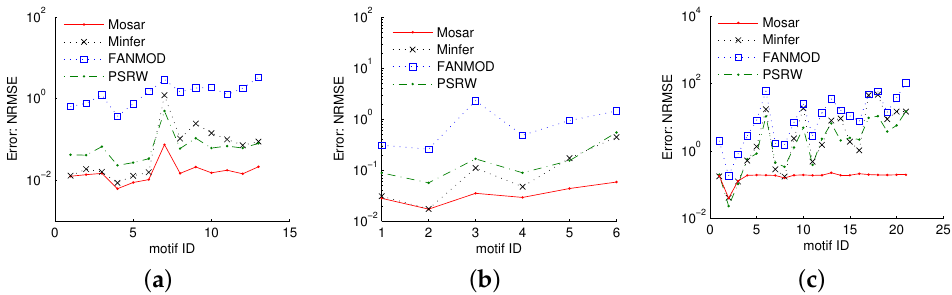
Figure 11. Accuracy of our method for estimating motif concentrations in comparison with state-of- the-art methods: ( a ) (Flickr) p = 0.01, three-node directed motif concentrations; ( b ) (soc-Epinions1) p = 0.1, four-node undirected motif concentrations; ( c ) (com-Amazon) p = 0.2, five-node undirected motif concentrations.